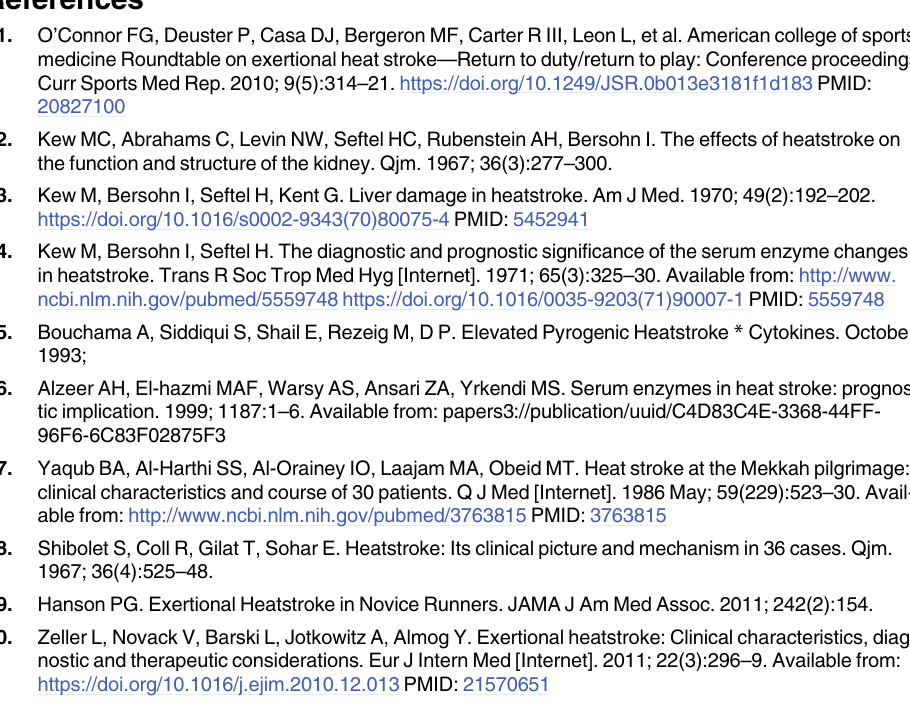
S4 Table. Liver function/muscle Injury—Median laboratory values in patients, during 14 days of EHS follow-up. S5 Table. Blood counts & coagulation—Mean laboratory values and percent of patient-val- ues relative to reference range, during 14 days of EHS